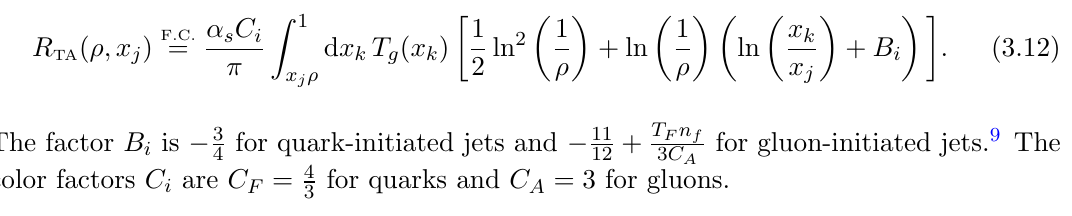
color factors C i are C F = 4 for quarks and C A = 3 for gluons. 3 9 The (cid:13)avor-changing process g ! q (cid:22) q is captured by the B i term. Note that, to NLL accuracy, the integral over T g ( x k ) drops out of the term proportional to B i , which justi(cid:12)es ignoring the (cid:13)avor change of the track function in our